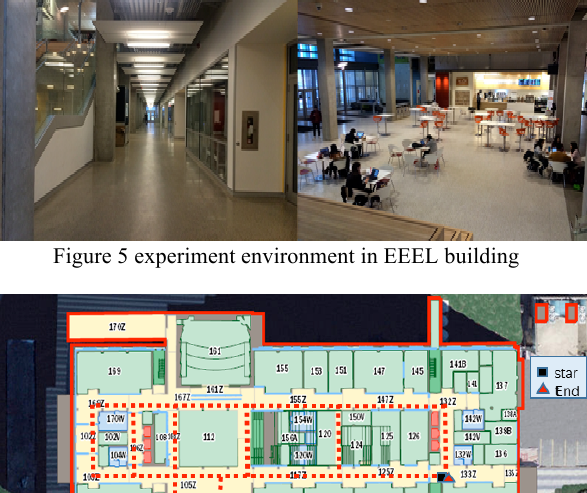
Figure 8. Reference trajectory of the test Figure 9 shows the Wi-Fi fingerprint estimated position, and Figure 10 is the INS/Wi-Fi integrated position. We can see that there are jumping points in the Wi-Fi Fingerprint solution. However, when we aid the Wi-Fi position into the system, it is clear to see that the integrated algorithm can complement each method and provide a better lower filter solution, but there is still a big drift in the trajectory.